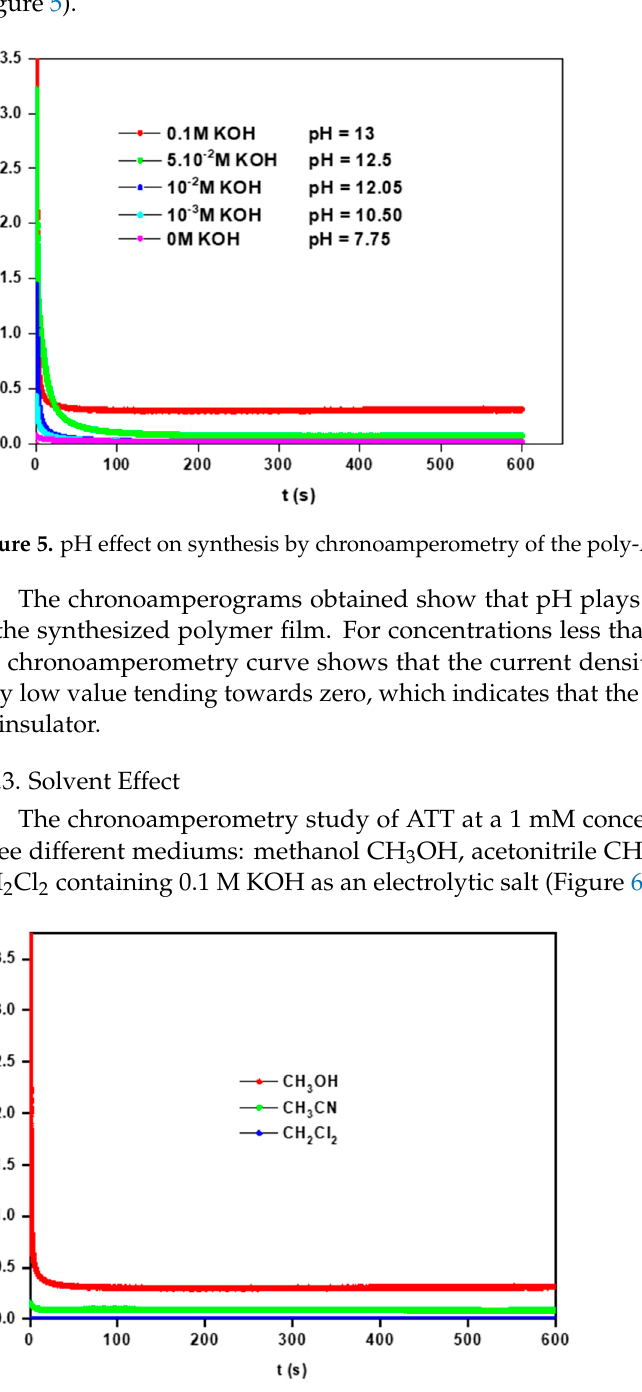
Figure 6. Chronoamperograms recorded in 60Cu-40Zn brass polarized at 1.15 V/Ag-AgCl in different solvents.